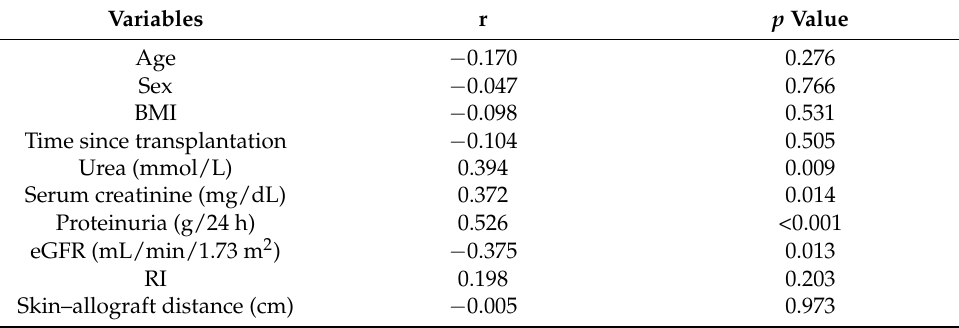
Table 3. Correlations between renal stiffness and baseline parameters.